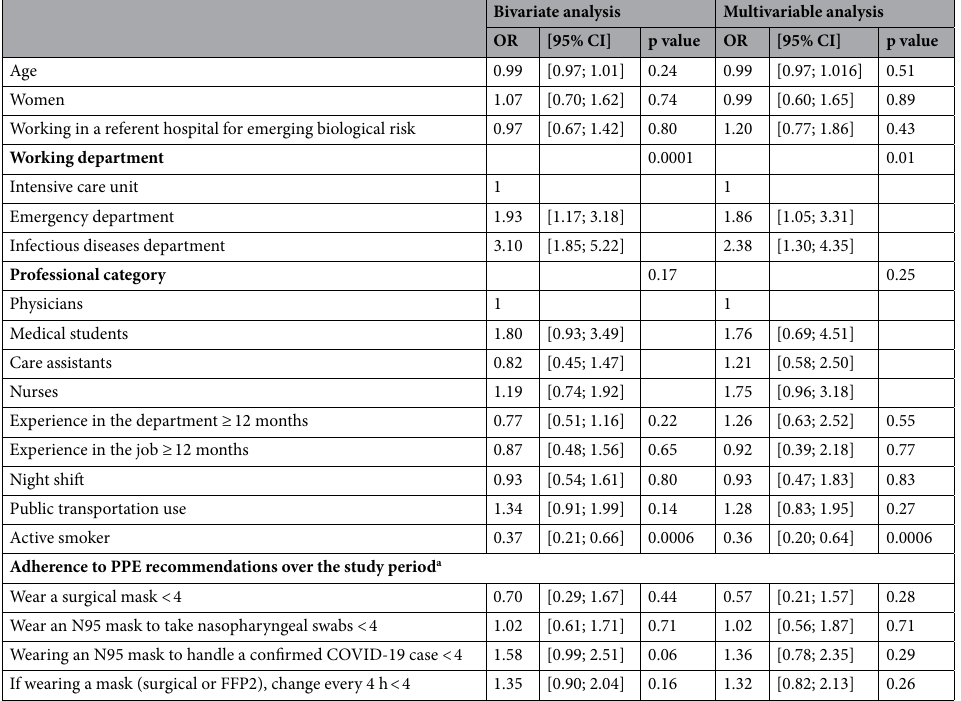
Table 5. Risk factors of laboratory-confirmed SARS-CoV-2 infection at month 3 in high-risk healthcare workers, accounting for adherence to personal protective equipment recommendations (after imputation of missing data; N = 916)). Data are n (%) for qualitative variables; median [interquartile range] for quantitative variables; OR: odds ratio; CI: confidence interval. a Collected at the end of the study on a 5-point Likert scale (0 = never to 5 = systematically), reported as the proportion of HCW rating 4 or 5; PPE: personal protective